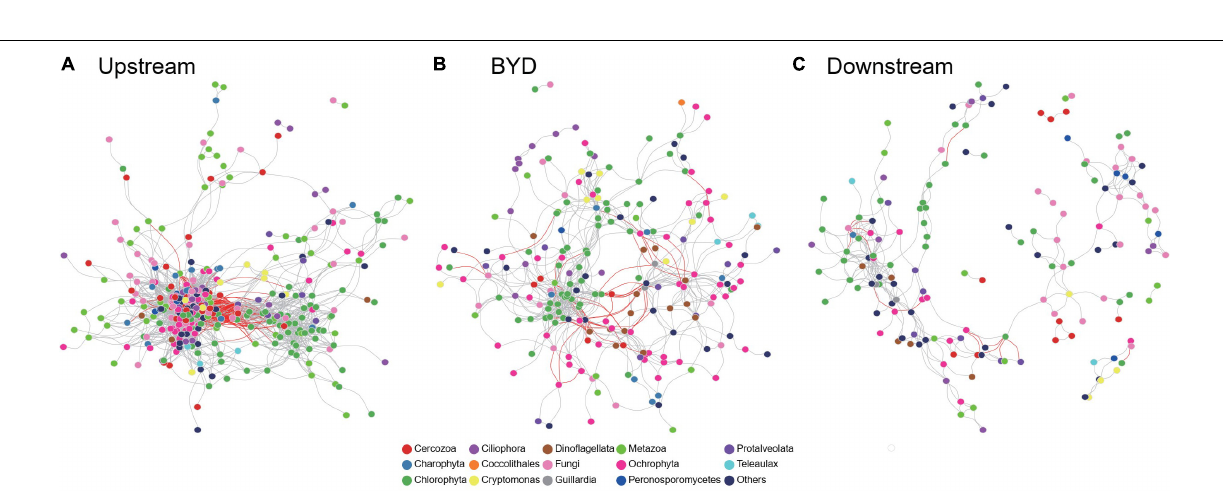
FIGURE 6 | Co-occurrence network of microeukaryotic communities at (A) upstream, (B) BYD, and (C) downstream. Circle nodes represent OTUs. Edges represent Spearman correlations (only strong and significant relationships with Spearman’ s r > 0.8 or r < –0.8 and P < 0.05 are shown). The gray and red lines indicate positive and negative correlations,